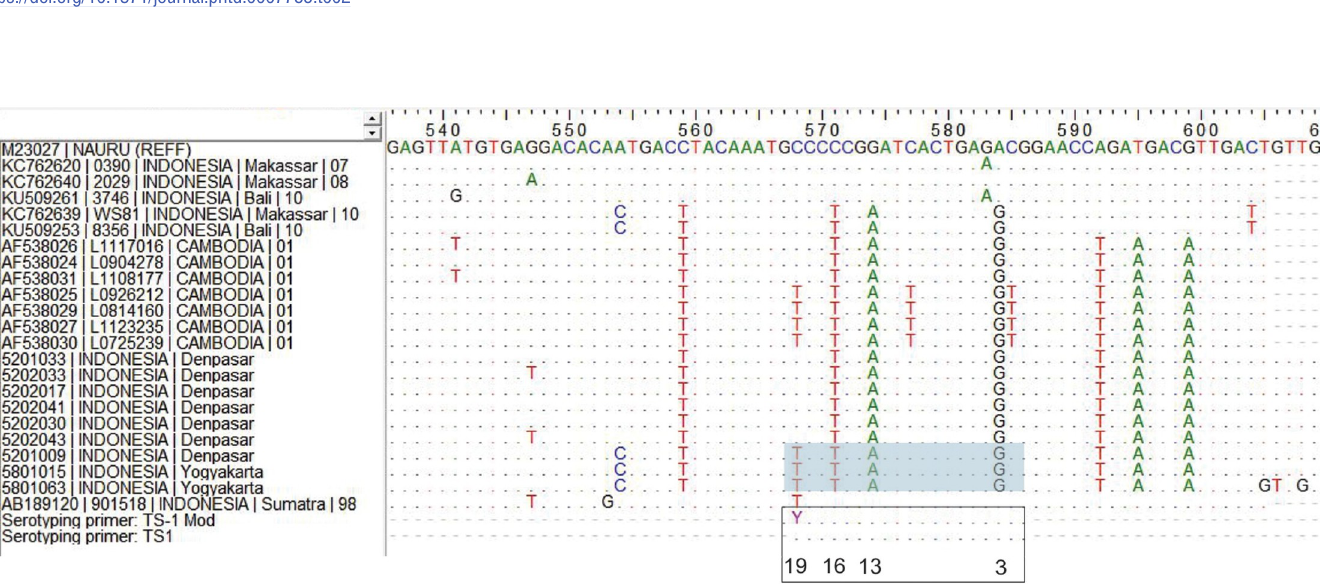
Fig 5. Nucleotide substitutions in TS-1 annealing site (nucleotide 568–586) that affected DENV-1 identification. Alignment of sequences covering the TS1 annealing region of AFIRE DENV-1 with other DENV-1 recently circulating in Indonesia as well as DENV-1 Cambodia (2001), with the prM sequence of DENV-1 Nauru/74 (GenBank Accession No M23027) as numbering reference in positive strand. Dots show similarity of nucleotides in their respective positions. Black arrow shows direction of amplification. Numbers below TS1 Mod sequence indicate nucleotide position where mismatches between the TS-1 primer and viral RNA template occur. The three AFIRE specimens that have the TS-1 mutation are 5201009, 5801015, and 5801063, the TS-1 annealing site is highlighted in grey. The sequences were submitted to GenBank under accession numbers MK634700 to